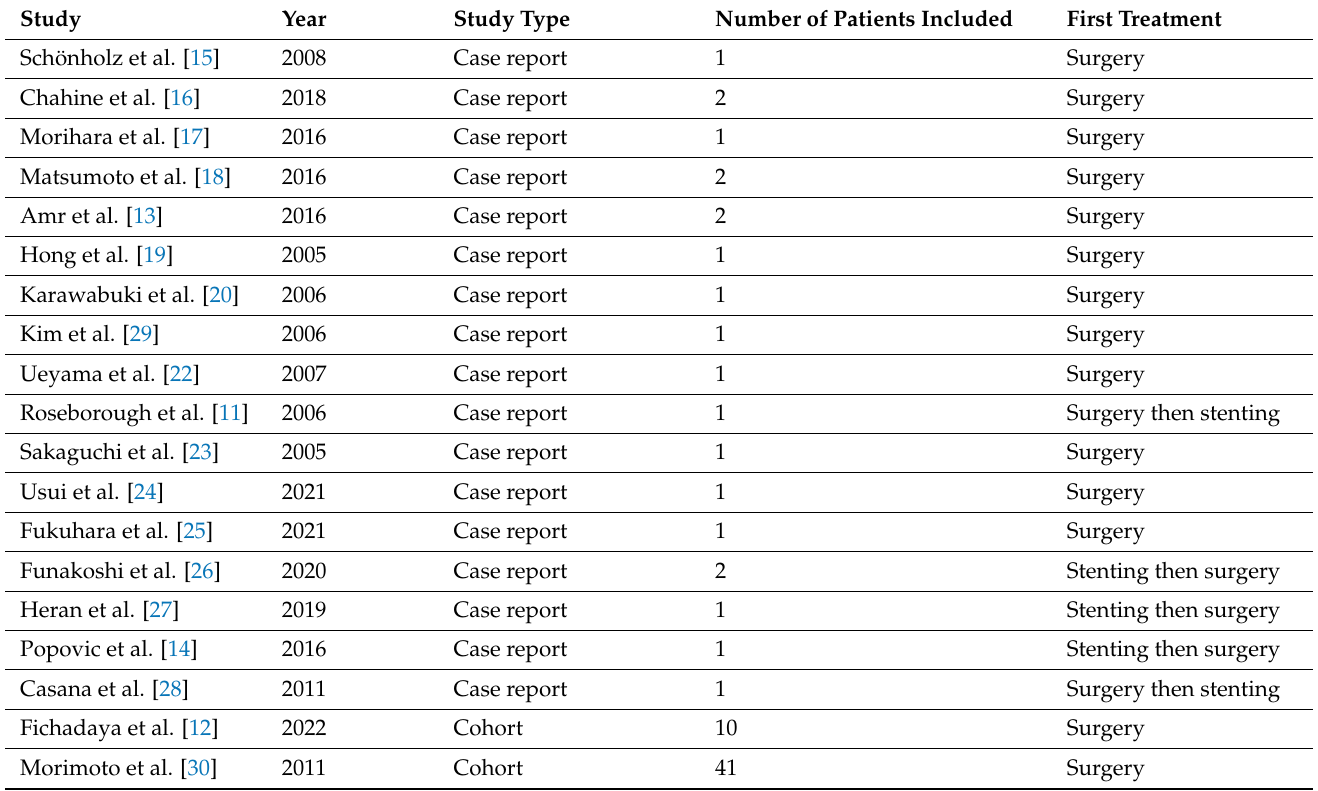
Table 2. Summary of included